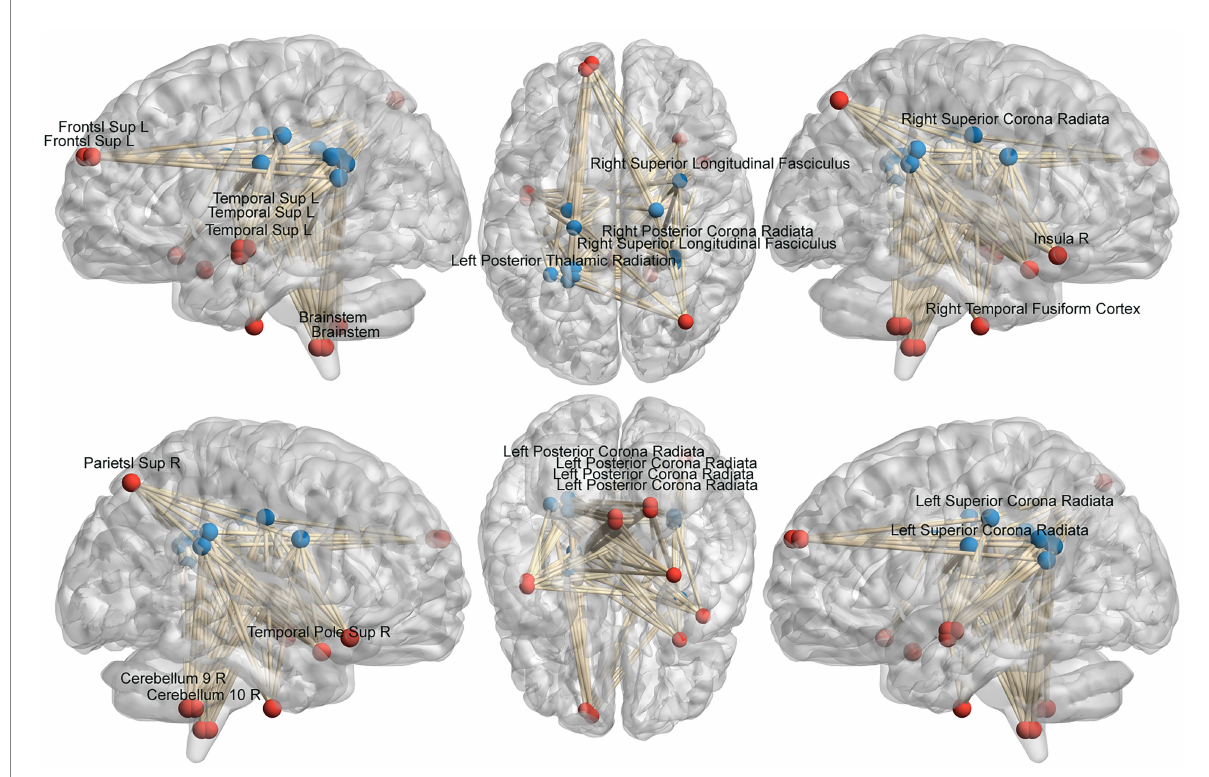
FIGURE 2 Schematic diagram of the abnormal functional covariance connections between 13 gray matter voxels and 11 white matter voxels identified by FCS analysis for the PD and HC groups. The red balls represent gray matter voxels, and the blue balls are the white matter voxels. PD: Parkinsons’s disease, HC: healthy control.